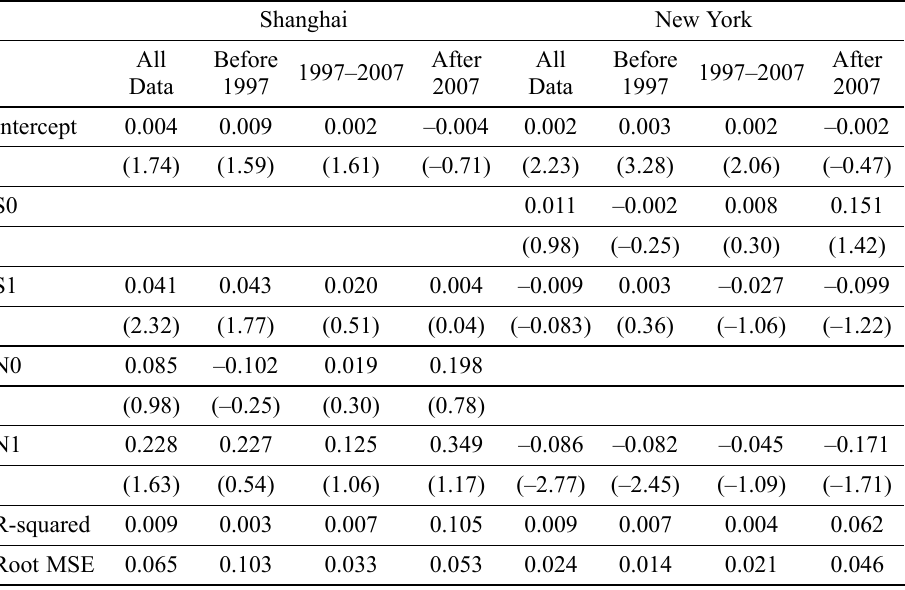
Table 7. Regressions of rate of return of Shanghai and New York stock prices The table presents the regressions of rate the return of shanghai and New York stock prices on the one-lag return and the return and one-lag return of the other stock exchange in total sample and three subsamples: before 1997, after 1997 and before 2007, and after 2007. The rate of re- turn is calculated as the change in the natural logarithm of the price index in a given period. The volatility of returns is calculated as the absolute value of the change in the natural logarithm of the price index in a given period. The price index is obtained from DataStream Equity Indices. S0 represents the raw rate of return of Shanghai stock prices while N0 represents the raw rate of return of New York stock prices. S1 represents the one-lag of the rate of return of Shanghai stock prices while N1 represents the one-lag of the rate of return of New York stock prices. We also report R-squared and Root MSE. T -statistics are provided in the parentheses. The